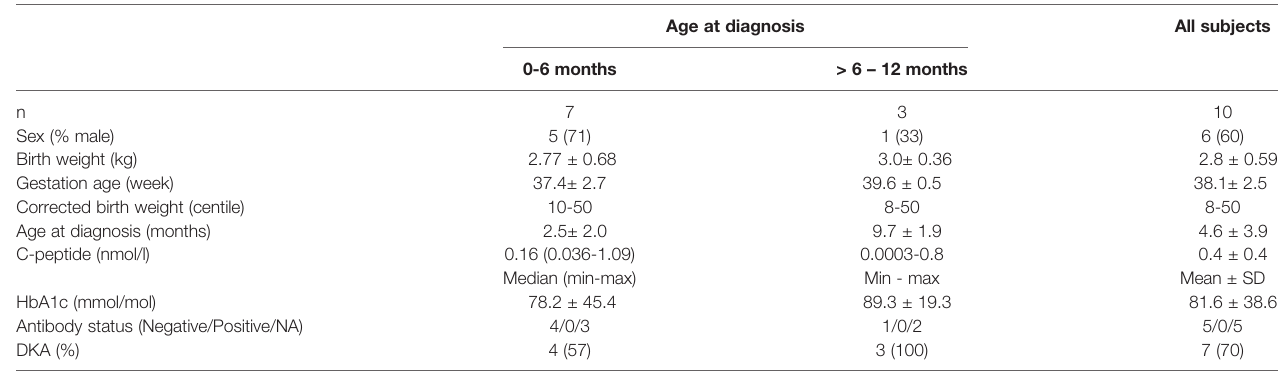
TABLE 1 | Clinical characteristics of probands at diagnosis of diabetes resulting from an INS gene mutation. Age at diagnosis All subjects